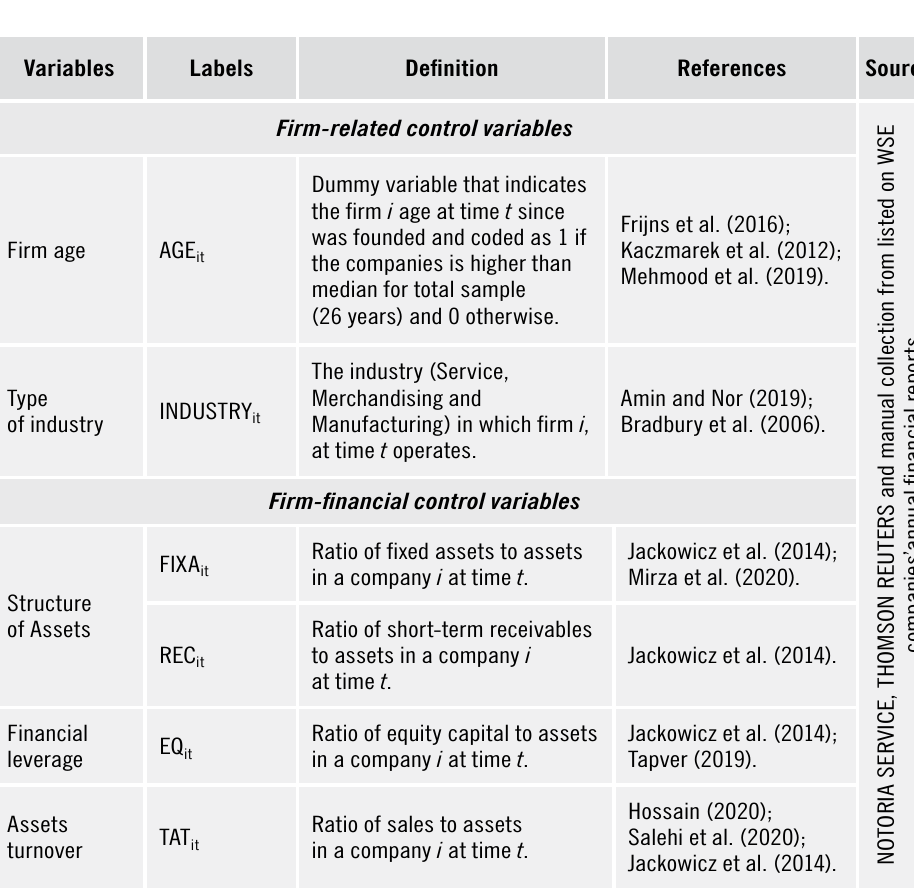
Table 3. Control